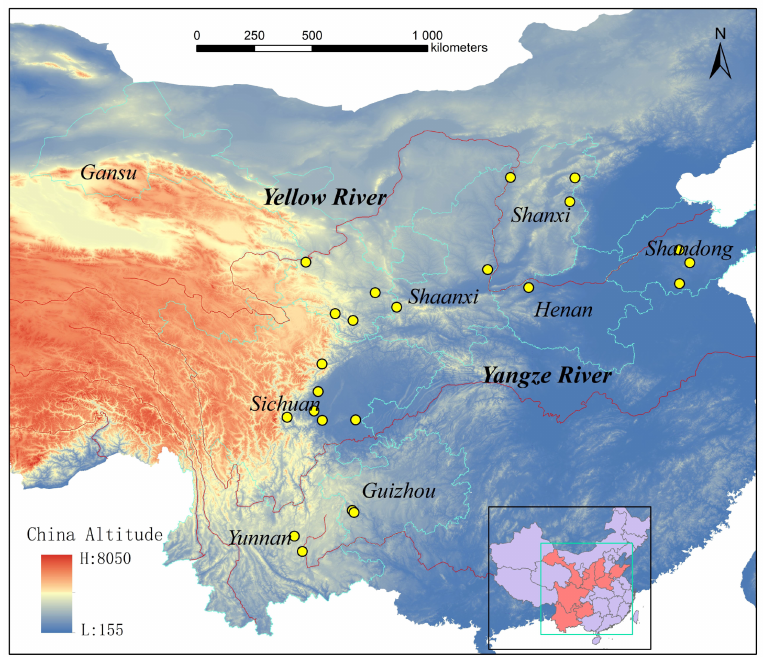
Figure 2. Distribution of 373 Zanthoxylum samples in 23 sampling sites in China. Small filled yellow circles represent the sampling